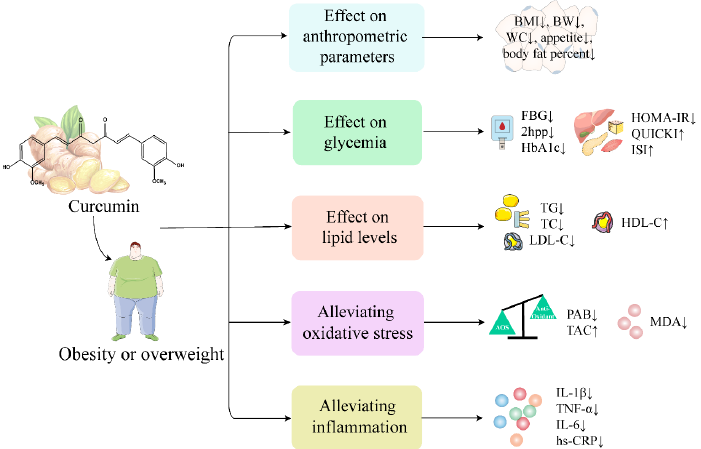
Figure 3. The therapeutic effects and potential mechanisms of curcumin on obesity. ↑ indicates increase and ↓ indicates decrease. Specifically, curcumin can alleviate inflammation by decreasing the levels of IL- 1β, IL -6, TNF- α and hs-CRP. Curcumin alleviates oxidative stress by decreasing the levels of MDA and PAB and increasing the expression of the antioxidant ’ s TAC.